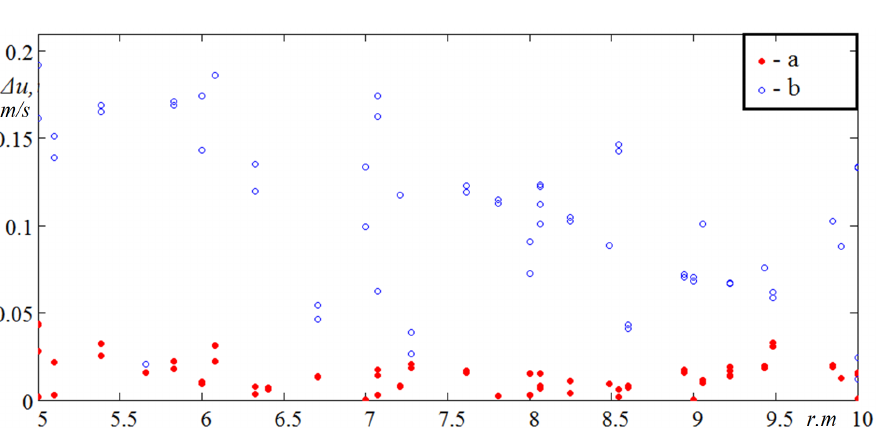
Figure 2. The dependences of the error in solving test problem I on the cylinders radius: (a) using the method of cells fullness; (b) the case of a stepped boundary between two